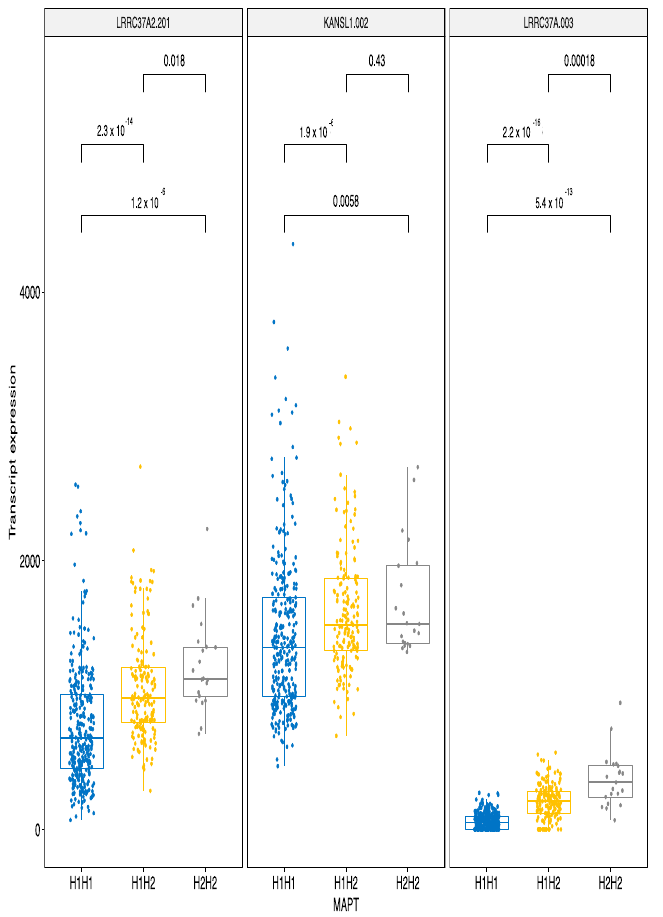
Figure 5. MAPT H2H2 haplotype upregulates several transcripts, three with the largest β values are illustrated here. Even a single H2 variant is sufficient to increase the expression of given transcripts. The bars indicate pairwise comparisons and respective p -values after the Wilcoxon test.